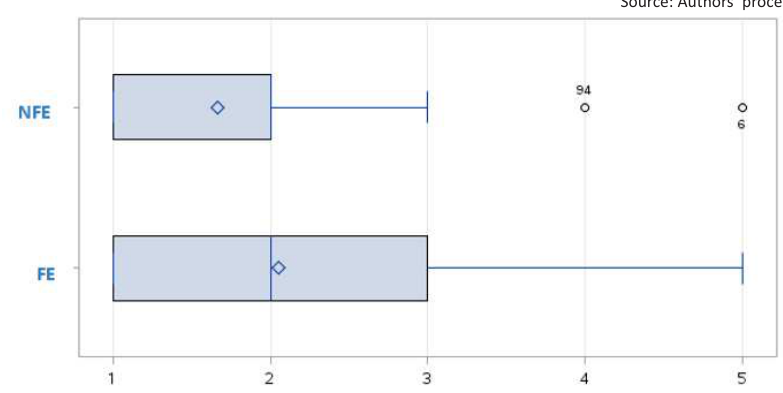
Figure 4. Box-plot ( H4